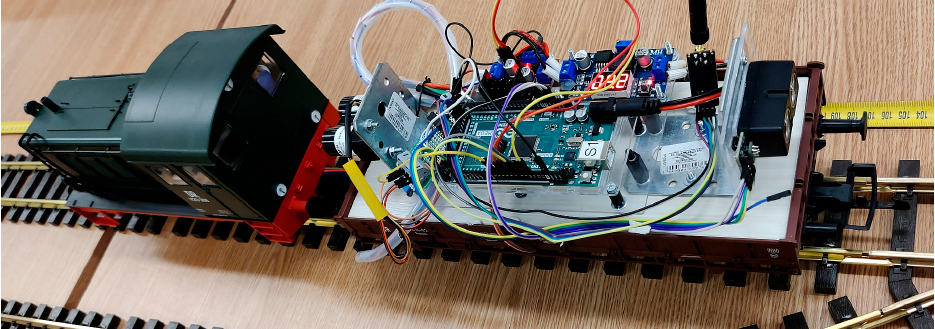
Figure 8. Mobile platform (SLAVE#1) equipped with LiDAR.